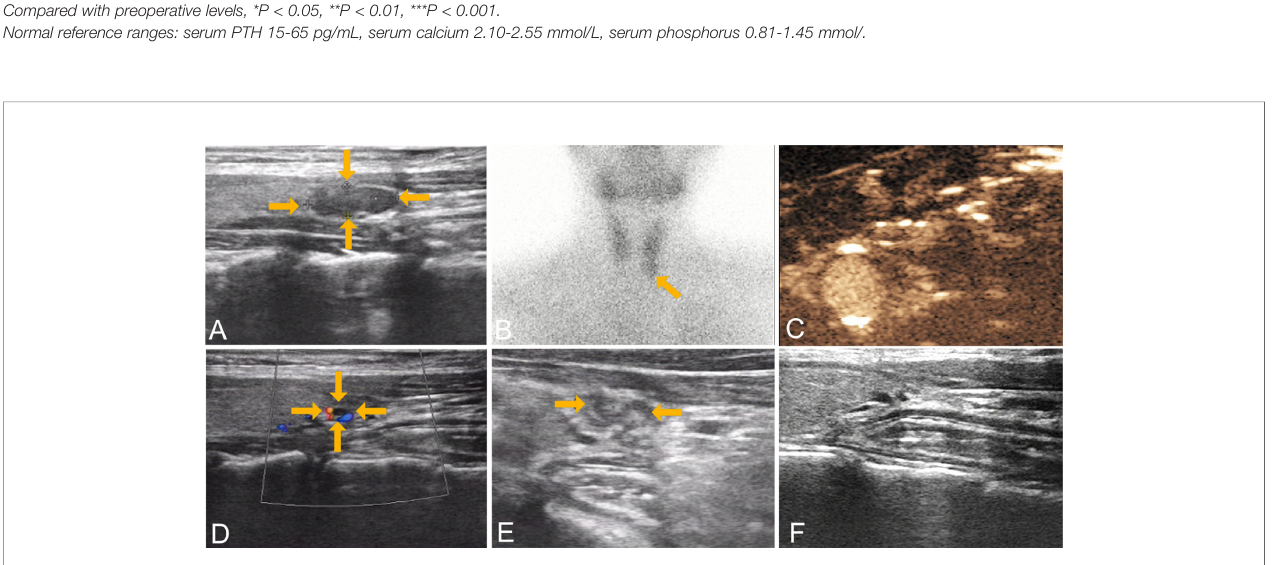
FIGURE 1 | Images from a 30-year-old female with a left lower parathyroid adenoma (13.0 mm × 4.4 mm × 1.3 mm) who underwent microwave ablation therapy. (A) preoperative gray scale ultrasound; (B) preoperative radionuclide scanning; (C) immediate contrast-enhanced ultrasound after ablation; ultrasound examination at three months (D) , six months (E) and twelve months (F) . Shown by ultrasound, the volume reduction rates were 92%, 98% and 100%, respectively. PHPT, primary hyperparathyroidism; MWA, microwave